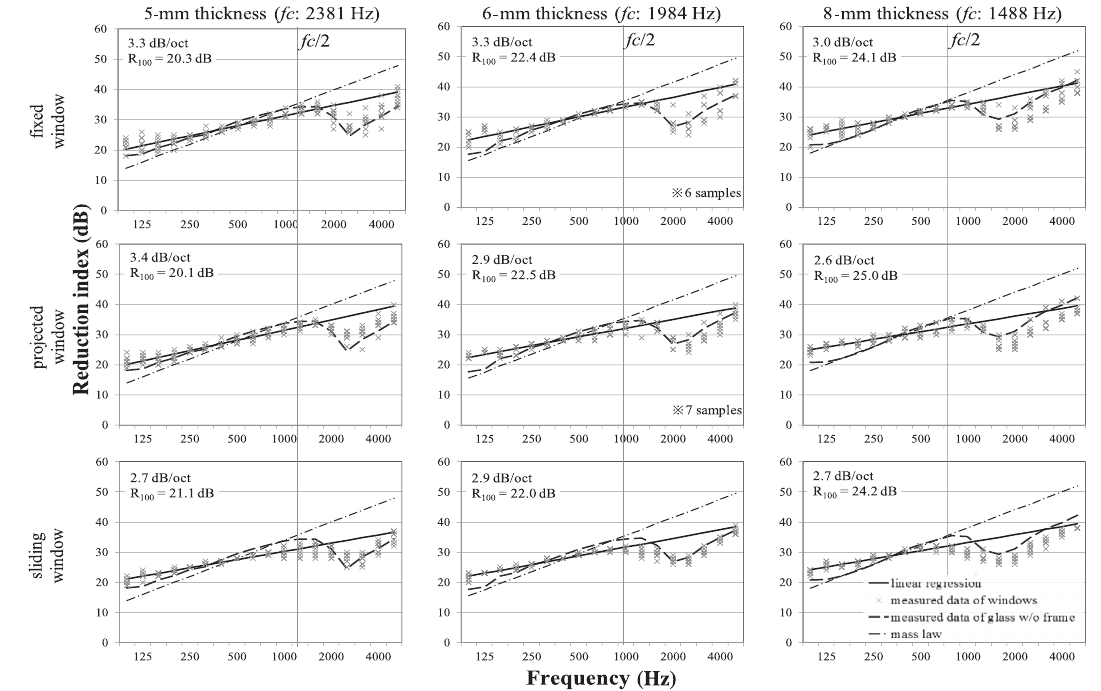
Reduction indices of ten samples for each condition. Solid lines show the results of linear regression for an average of ten samples in the range 100 Hz to fc /2. Dashed lines and dash– dotted lines, respectively, represent measured values of a single pane of glass without a frame and calculated values using the mass